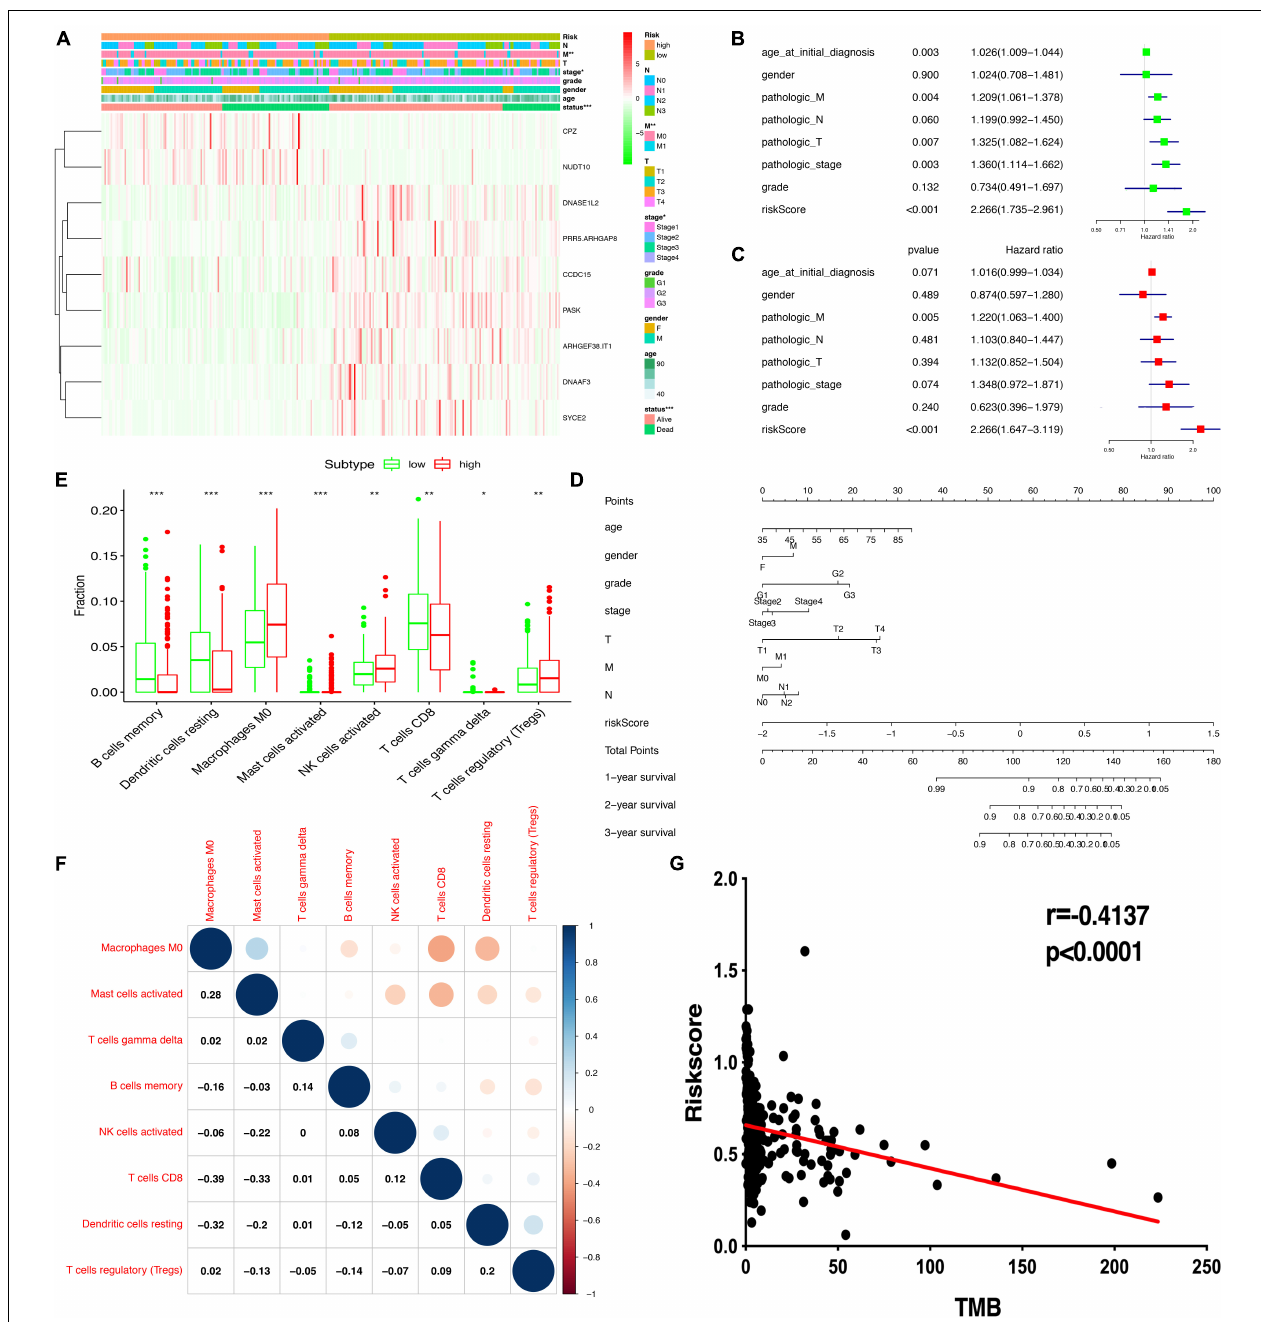
FIGURE 6 | Correlation of risk scores based on the prognostic model with clinical characteristics, immune cells, and TMB. (A) Heatmap of clinical correlation between high and low-risk score groups. (B) Univariate Cox regression analysis of risk factors. (C) Multivariate Cox regression analysis of risk factors. (D) The risk score and clinical information assessment nomogram to evaluate STAD prognosis (1-, 2-, and 3-year survival rates). (E) Boxplot shows the ratio differences of eight immune cells between the high- and low-risk score groups. The Wilcoxon rank sum was used for the significance test. (F) The correlation between these eight immune cells. (G) The correlation of risk scores based on the prognostic model with TMB. ∗ p < 0.05, ∗∗ p < 0.01, and ∗∗∗ p <